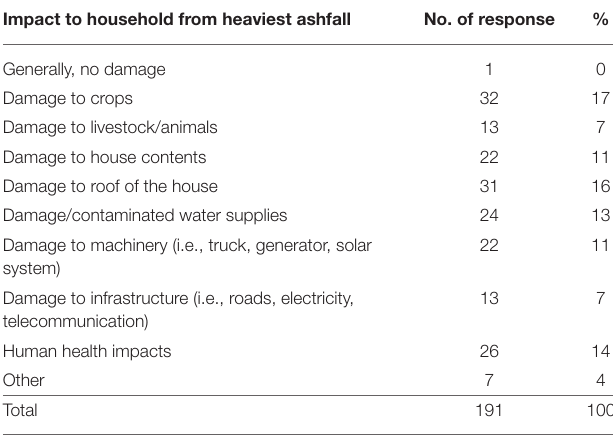
TABLE 4 | Questionnaire interview results in heaviest impacts on household.